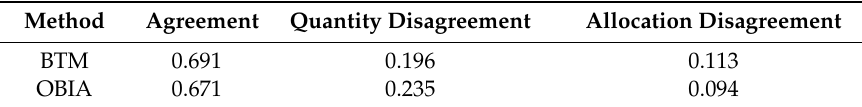
Table 4. Results of the agreement analysis.